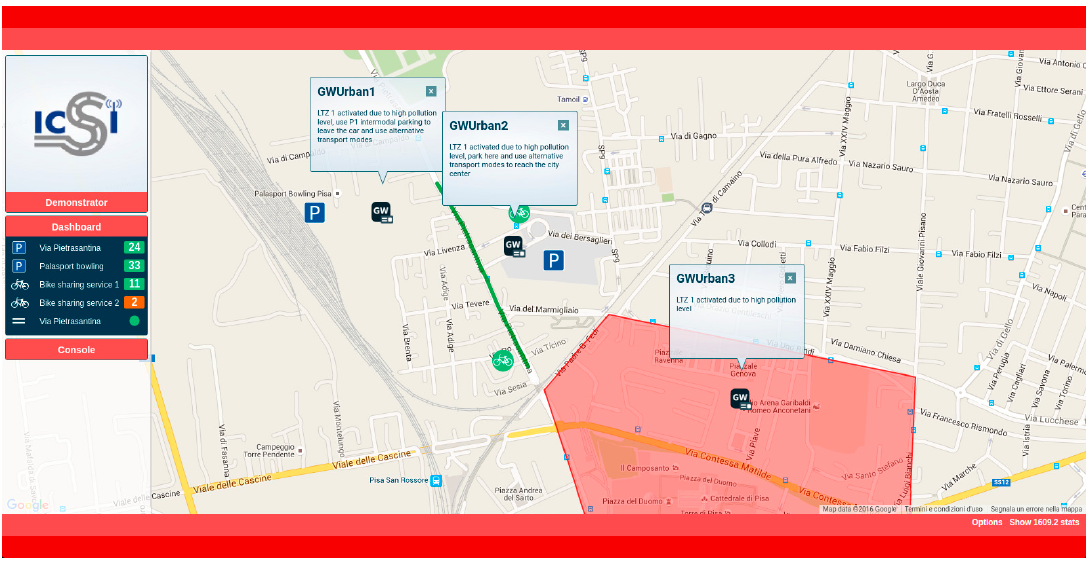
Figure 6. Demonstration Web Application.